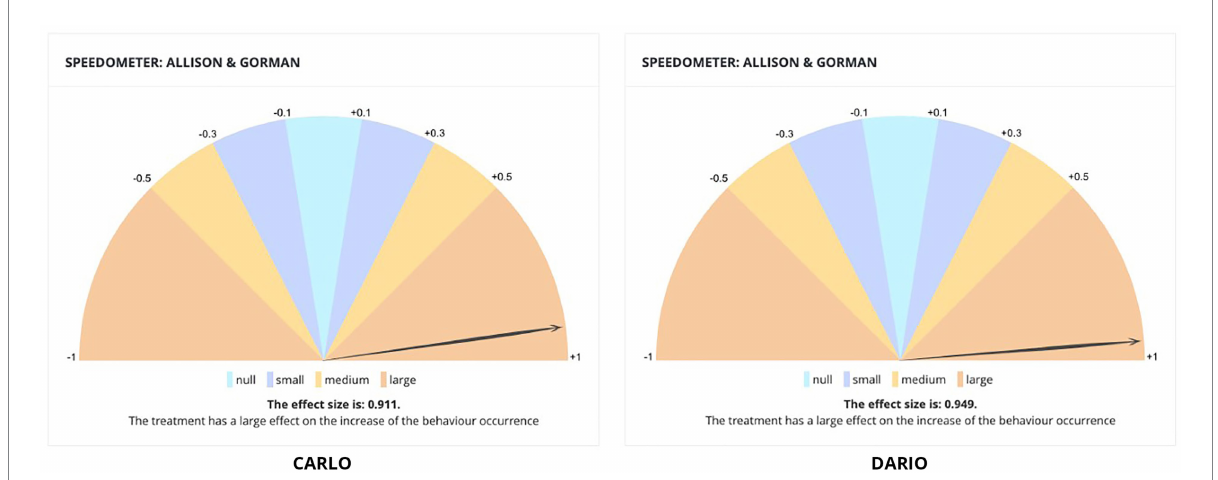
FIGURE 4 Screenshot of the BEHAVE application displaying the automatic calculation of the effect size of the